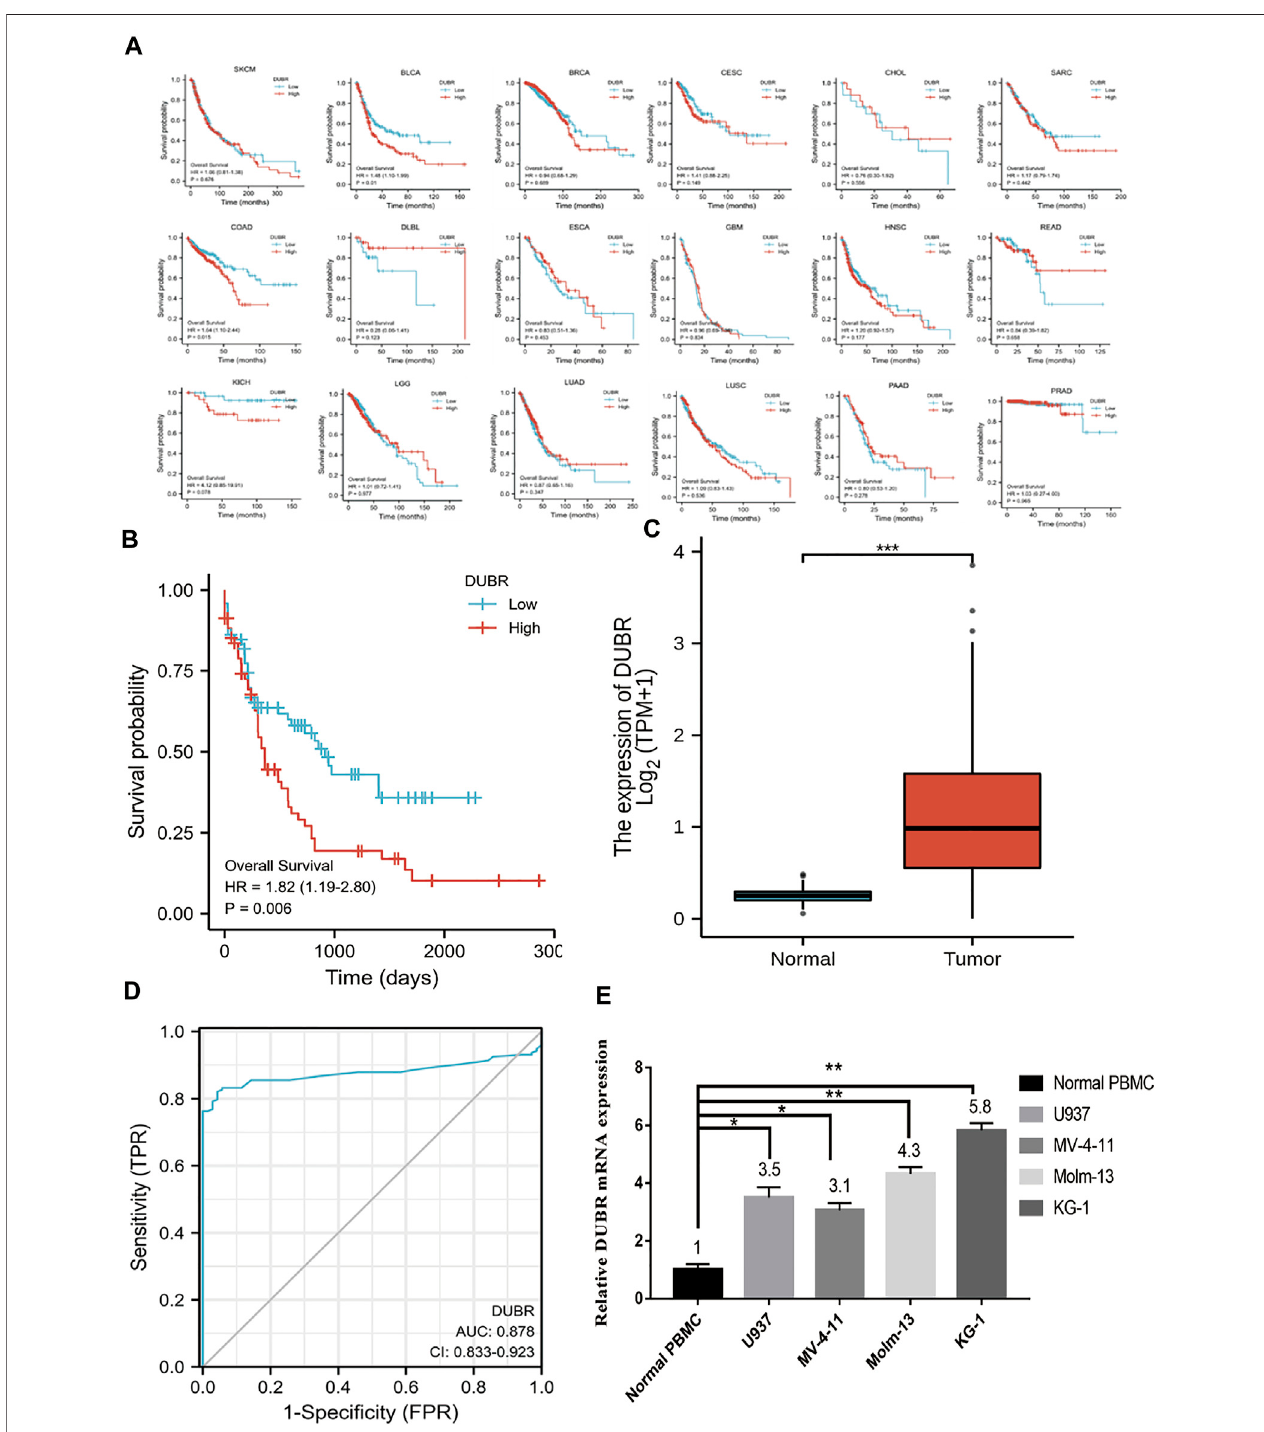
FIGURE 2 | Role of DUBR in predicting OS of different human cancers measured using the Gene Expression Pro fi ling Interactive Analysis (GEPIA) database. (A) Kaplan-Meier analysis of overall survival based on DUBR expression levels in SKCM, BLCA, BRCA, CESC, CHOL, SARC, COAD, DLBL, ESCA, HNSC, READ, GBM, KICH, LGG, LUSC, PAAD, PRAD, and LUAD. (B) Kaplan-Meier plot of OS of patients with AML having high DUBR expression, which was de fi ned as DUBR RNA expression higher than the median level, and lncRNA DUBR down-regulation ( p < 0.001). (C) lncRNA DUBR levels within LAML cells in comparison with normal subjects( p < 0.001).TCGA-deriveddatawereanalyzedbyGEPIA(http://gepia2.cancer-pku.cn).withtheuseofRNA-seqdatafromGTEx-derivedhealthytissues.TPM: TranscriptsPerKilobaseMillion. (D) PredictiveabilityofDUBR expression forAML sensitivity. (E) RT-PCR resultsof DUBR innormaltissueand LAMLcellline.* p < 0.05; ** p <